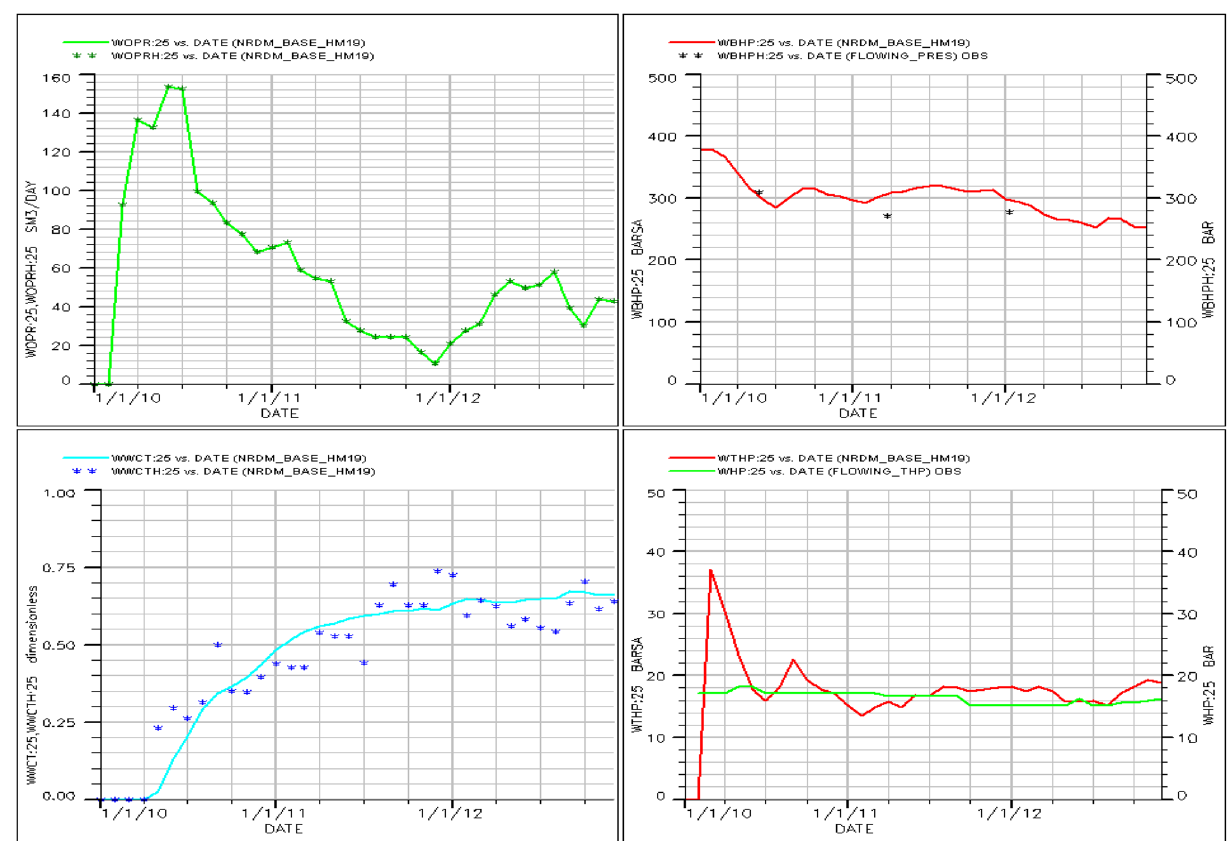
Fig. 10 Matching results of well